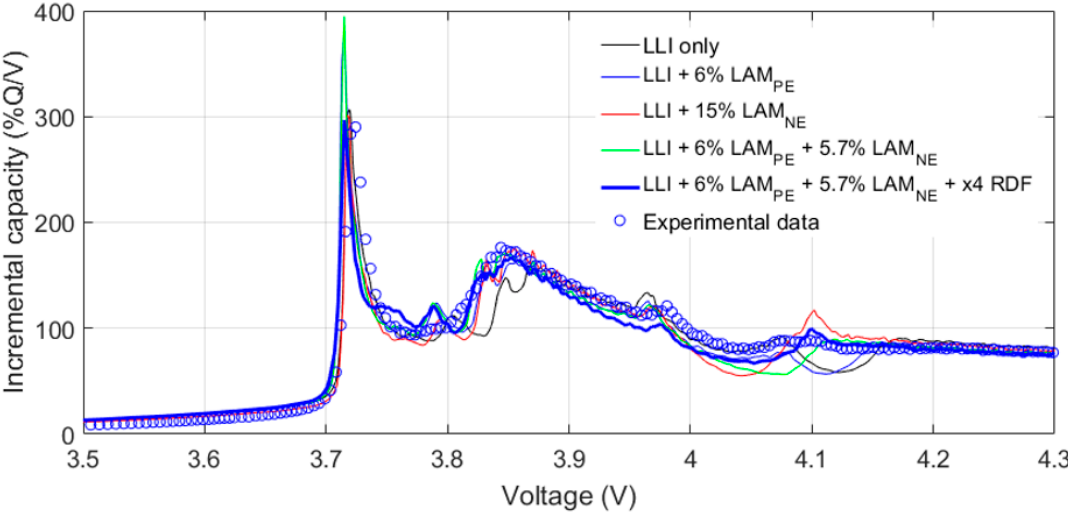
Figure 8. Final emulation results after 1000 cycles for cell #1.